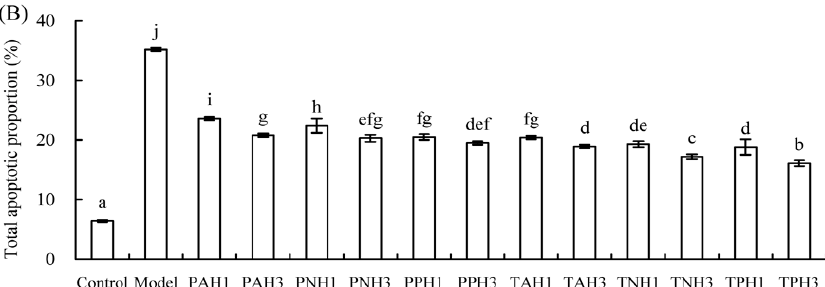
Figure 3. Total apoptotic proportions (%) of the osteoblasts exposed to 12 hydrolysates using cisplatin- ( A ) or EP- ( B ) induced apoptosis. Different letters above the columns indicate that one-way ANOVA of the means differs significantly ( p < 0.05).